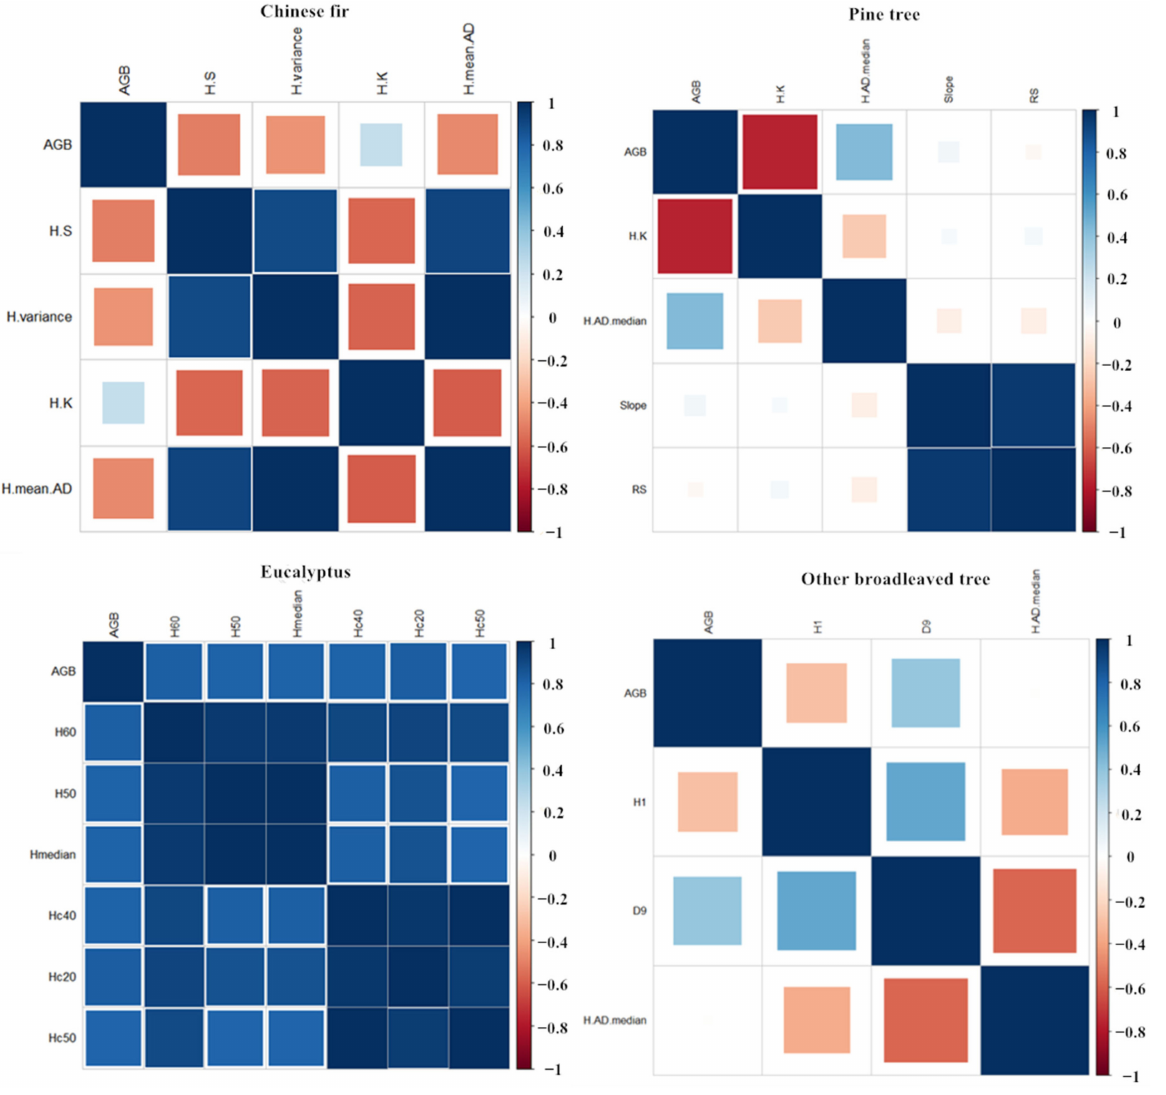
Figure 4. Features correlation of each tree